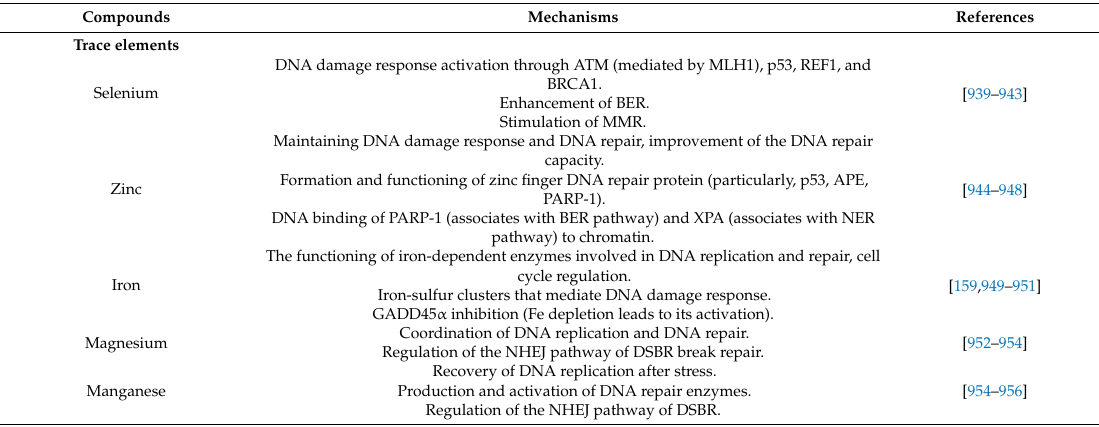
Table 4. Compounds that stimulate DNA damage response and